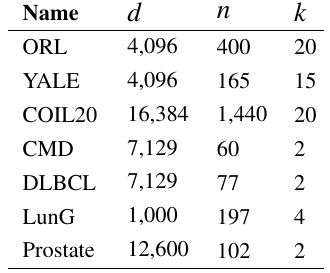
Table 3 The date information in the algorithm test